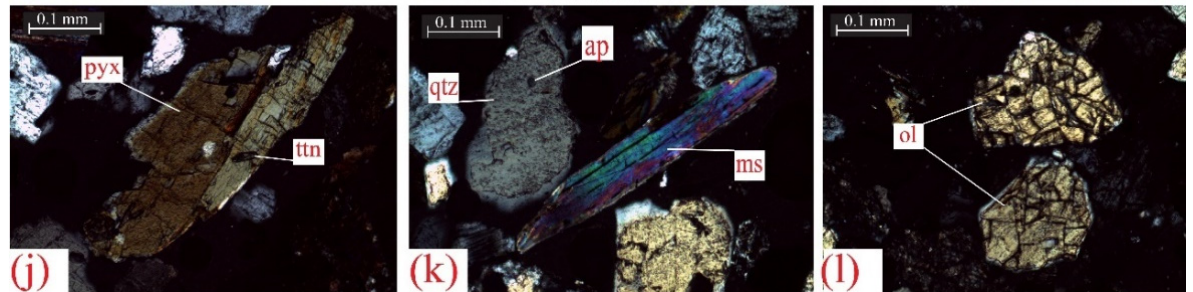
Figure 4. Microphotograph showing the average sediment composition of all the clusters ( a ) Biotite (bt), olivine (ol), ( b ) pyroxene (px), ( c ) actinolote (act) and tremolite (trm), ( d ) sericite (ser) and amphibolite (amph), ( e ) rutile (rt), ( f ) marble clast, ( g ) pyroxene (pyx), orthopyroxene (opx), apatite (ap), ( h ) sandstone clast with hematite as cementing material, ( i ) plagioclase (plag), ( j ) pyroxene (pyx) with sphene (titn) inclusion, ( k ) quartz (qtz) with apatite (ap) inclusion and muscovite (ms), ( l ) olivine (ol) in the samples collected from the study area (scale 0.1 mm). The presence of feldspar, notably plagioclase albite and alkali feldspar, indicates a volcanic origin (Figure 4i). The alkali feldspar, on the other hand, indicates a felsic igneous origin. Table 1. The mineralogical composition of samples in different clusters (C1, C2, C3, C4 and C5). Mineralogical